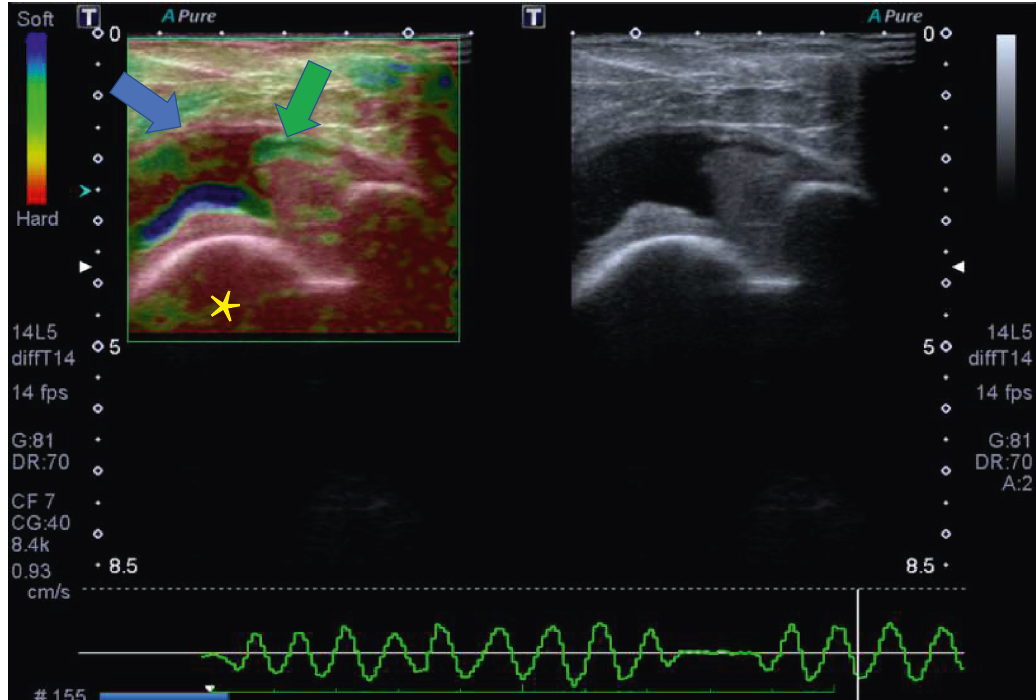
Figure 7: A 34-year-old patient with silicone implants for 5 years. Breast ultrasonography shows thickening of the breast implant capsule, associated with a granuloma in focal areas (green arrow). Intracapsular collection and intracapsular mass are also observed (blue arrow). The fluid collection is soft at elastography. The yellow asterisk shows the breast